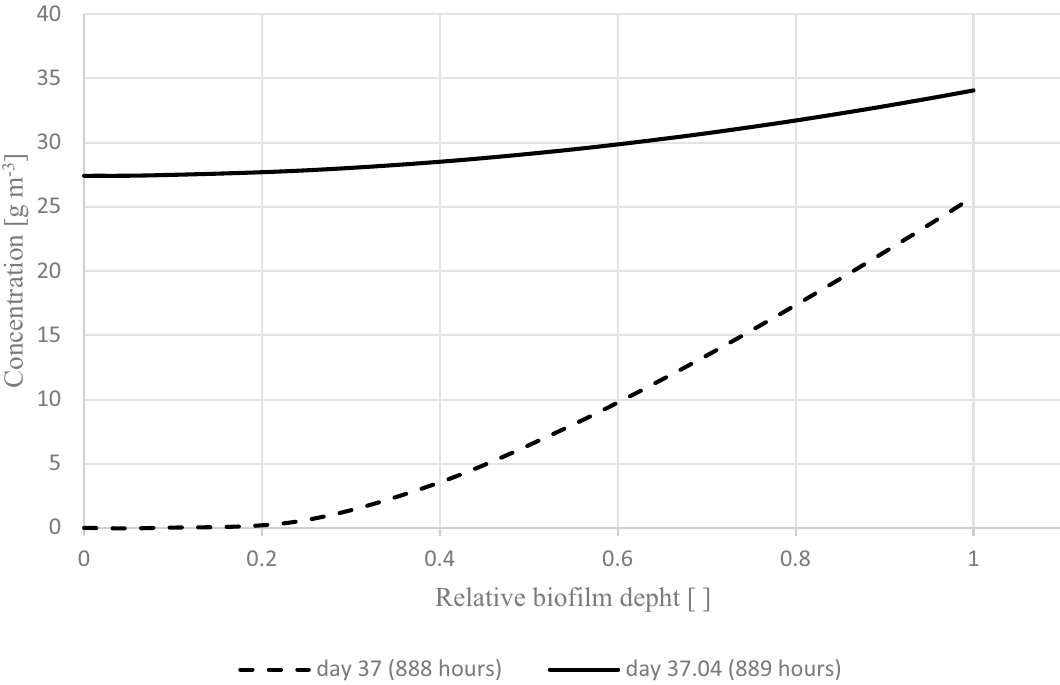
Figure 5. Predicted concentration in the biofilm by using the experimental inlet concentration, showing a sudden change from non-saturated to saturated biofilm within a single hour.